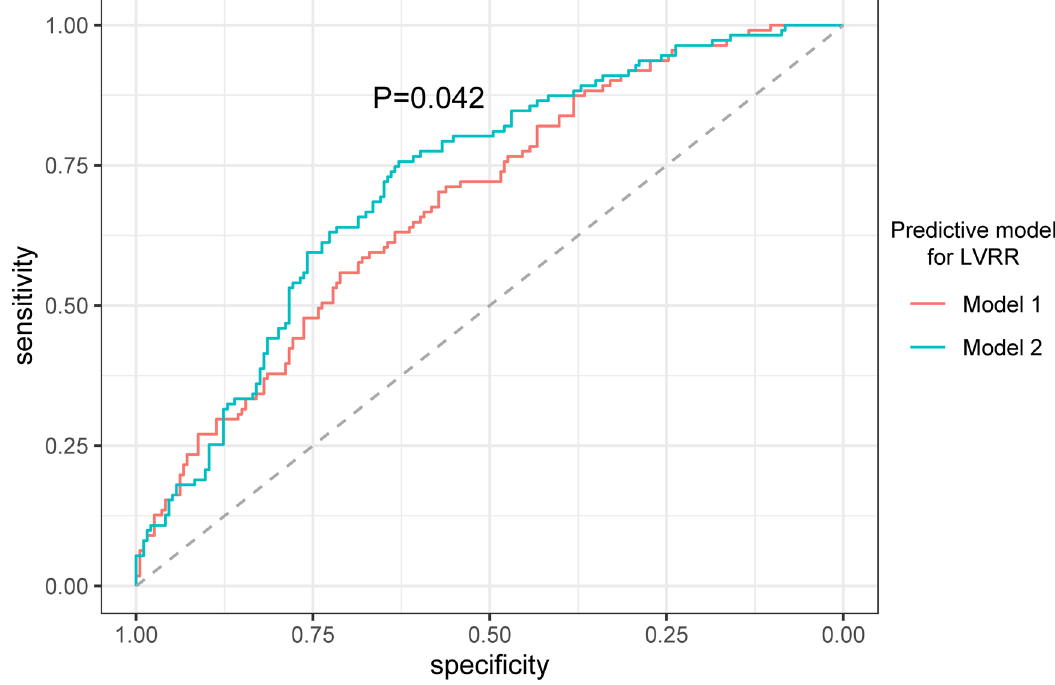
Figure 2. The receiver-operating characteristic curves (ROC) of the model before and after adding Big ET-1 in predicting LVRR. The basic prediction model (model 1) constructed using stepwise regression [including BMI, SBP, diagnosis of T2DM and the treatment with ACEI/ARB]. Model 2 included parameters in model 1 adding log 2-transformed Big ET-1.